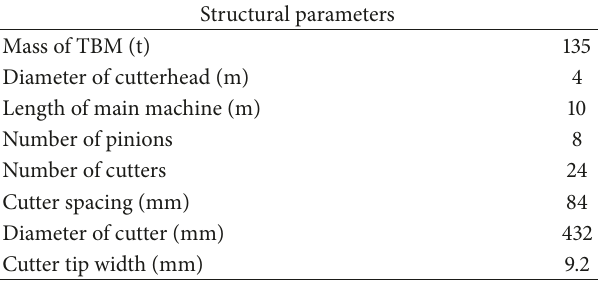
Table 1: Structural parameters in TBM dynamic model.